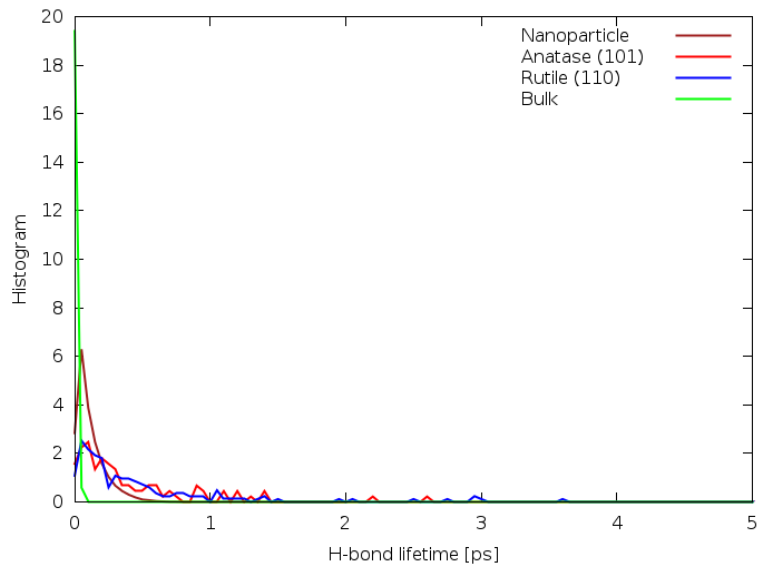
Figure 6. Average hydrogen bond lifetime for various systems simulated with DFTB. The y − axis is the frequency of that lifetime occurring, normalised to the same scale for all systems.